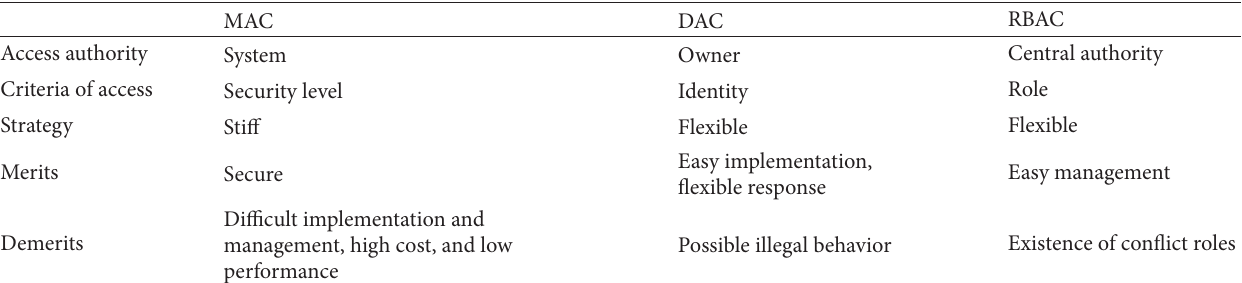
Table 1: Characteristics of MAC, DAC, and